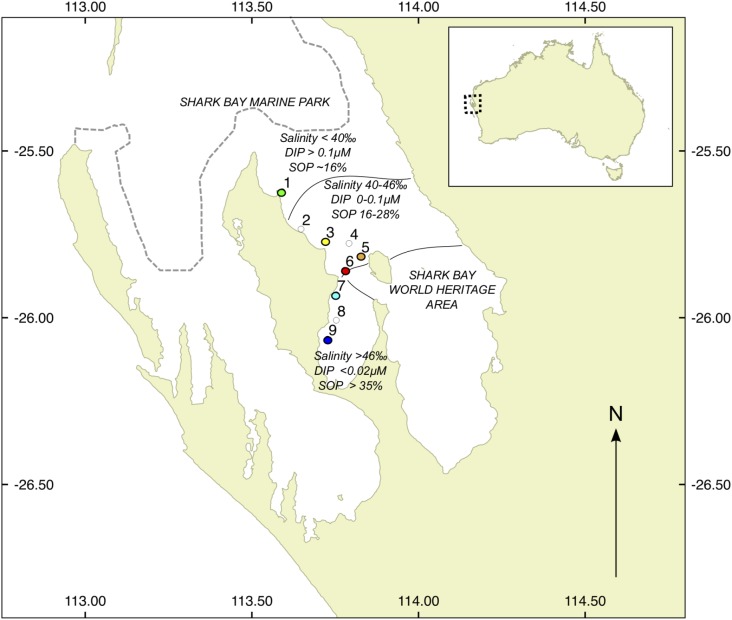
Location of study sites in Shark Bay, WA, Australia. Colored dots show sites where metagenomic profiles were generated, with colors corresponding to legends in later figures. White dots denote sites of additional samples from biogeochemical measurements. DIP, dissolved inorganic phosphate; SOP, sediment organic phosphorus.